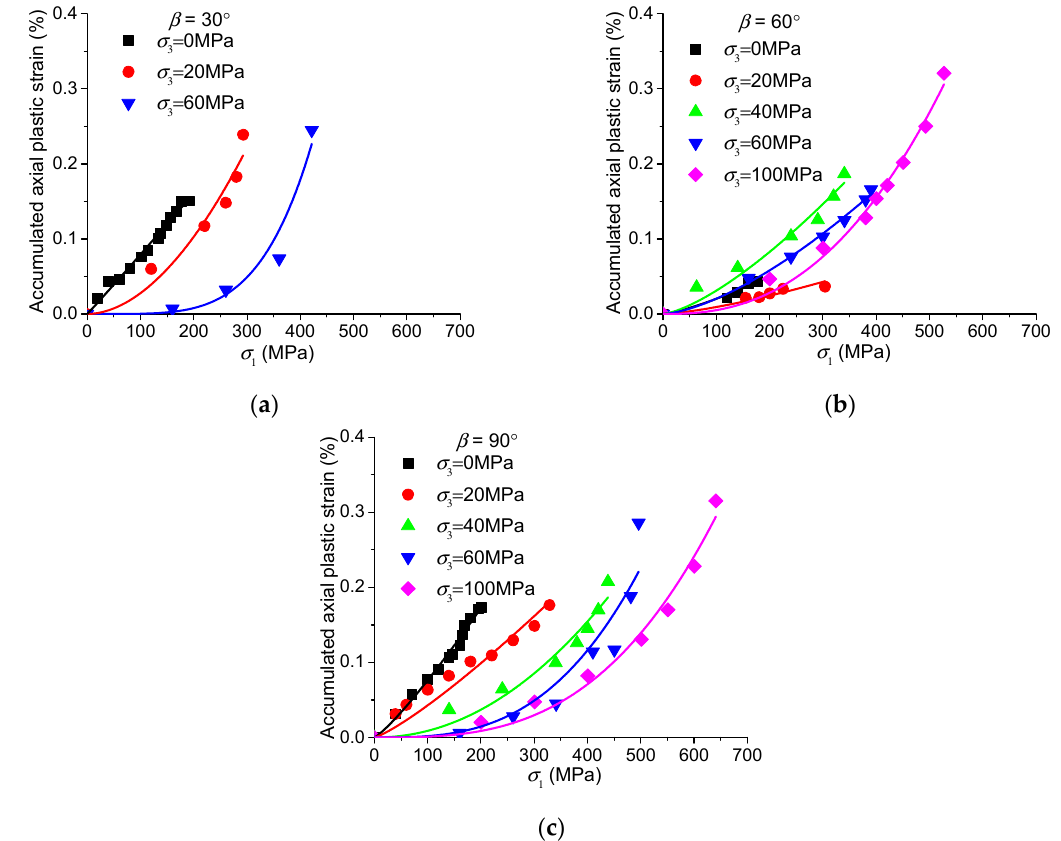
Figure A2. Accumulated axial plastic strain with the increase of axial stress for the shale samples with different oriented weak planes (( a ) β = 30 ° , ( b ) β = 60 ° , and ( c ) β = 90 °) under various confining pressures.